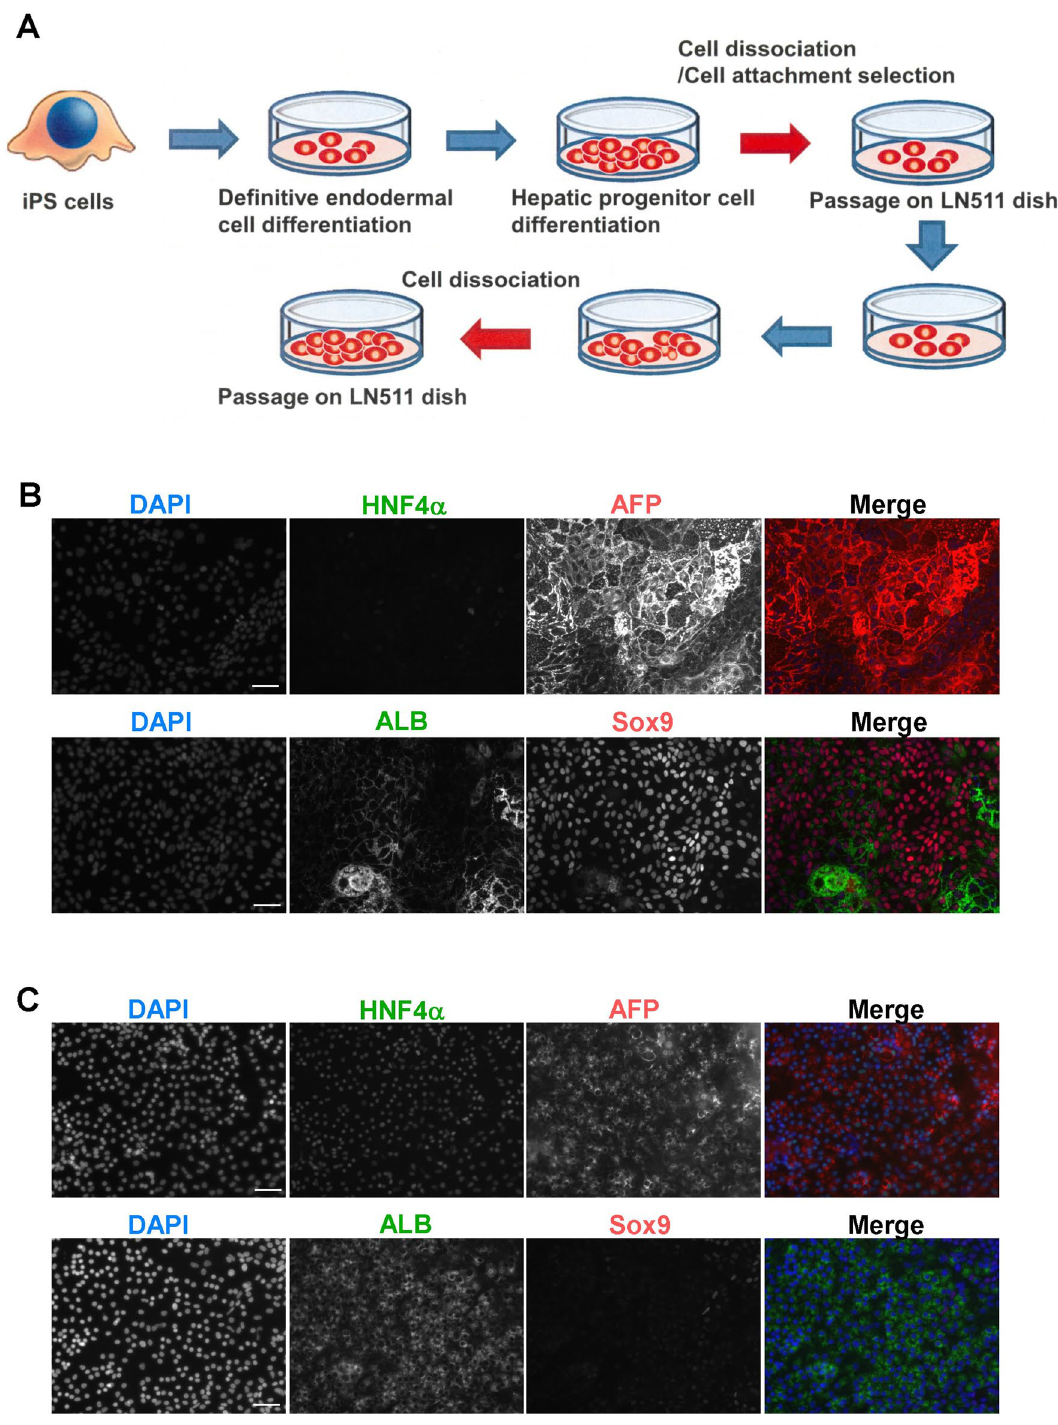
Figure 4. Establishment of human induced pluripotent stem cell (iPSC)-derived hepatoblasts. ( A ) The schema of the culture system of hepatoblasts derived from human iPSCs. Differentiation of human iPSCs into definitive endodermal and hepatic progenitor cells was induced under the suitable culture conditions. These cells were passaged several times on LN511-coated dishes. Expanded cells were used as human hepatoblasts. ( B , C ). Expression of progenitor and hepatocyte marker proteins of human hepatoblasts ( B ) and differentiated hepatocytes ( C ) derived from iPSCs. Passaged hepatoblasts were cultured and fixed using 4% paraformaldehyde. These cells were stained with hepatocyte marker proteins (ALB and HNF4α) and hepatic progenitor marker proteins (AFP and SOX9). Scale bar, 50